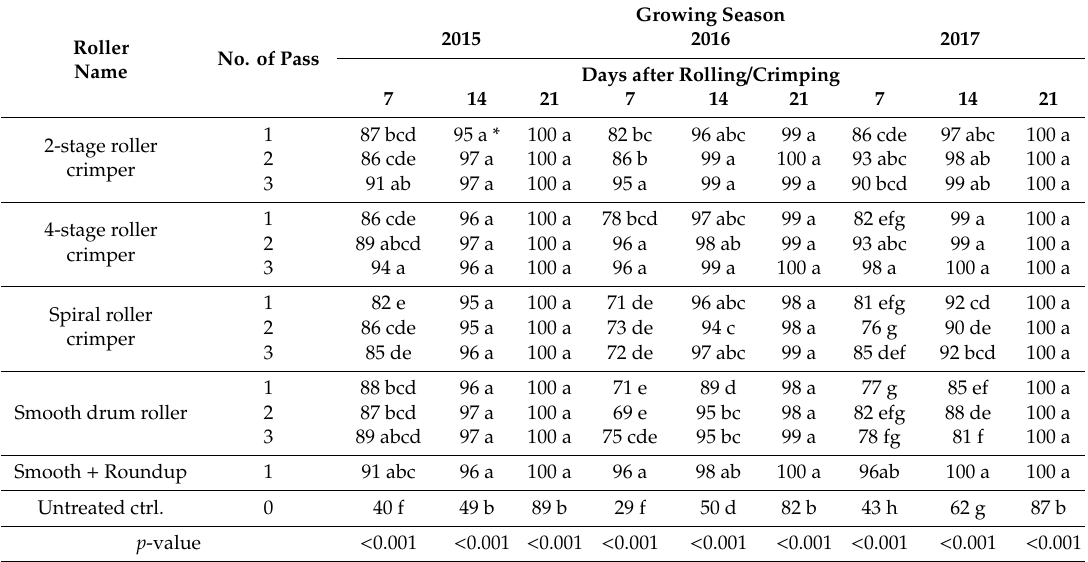
Table 4. Cereal rye kill rate results by rollers / crimpers (%) in 2015–2017 growing